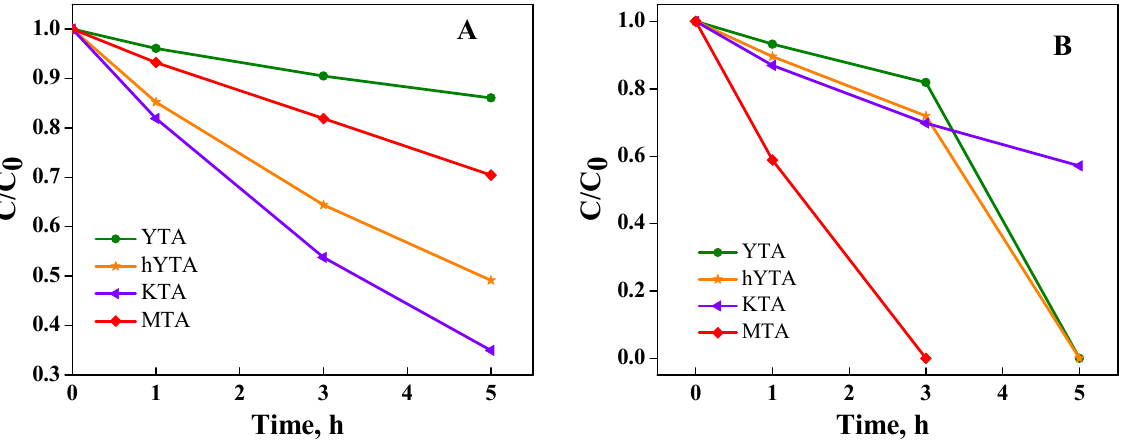
Figure 9. Photocatalytic degradation of amoxicillin under UV irradiation ( A ) and visible light ( B ) irradiation.